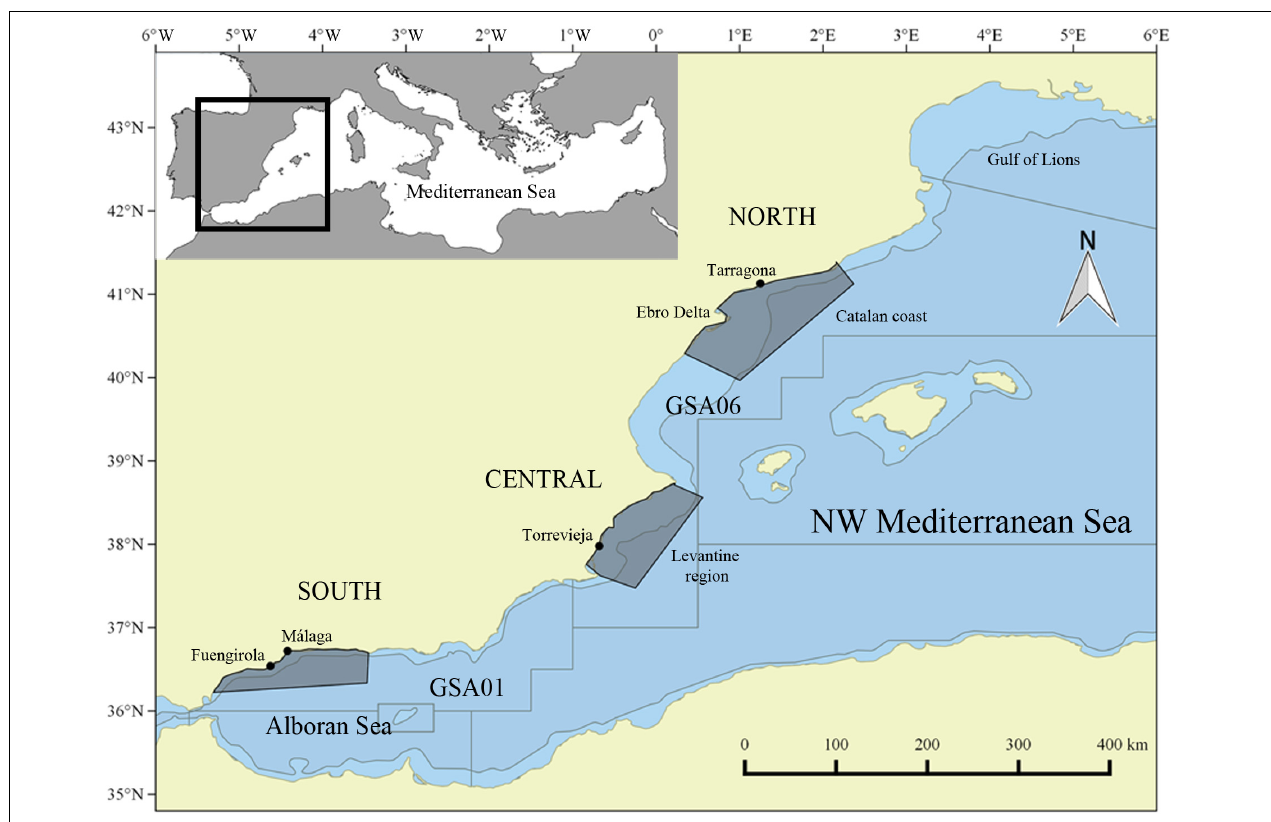
FIGURE 1 | Study area with the Geographical Sub Areas 06 and 01 delimitated. Sampling ports are indicated with a dot (Tarragona-North; Torrevieja-Central; Málaga, Fuengirola-South). The shaded polygon corresponds to the area from where the environmental data were extracted (north, central, and south). The bathymetric line corresponds to the 200 m